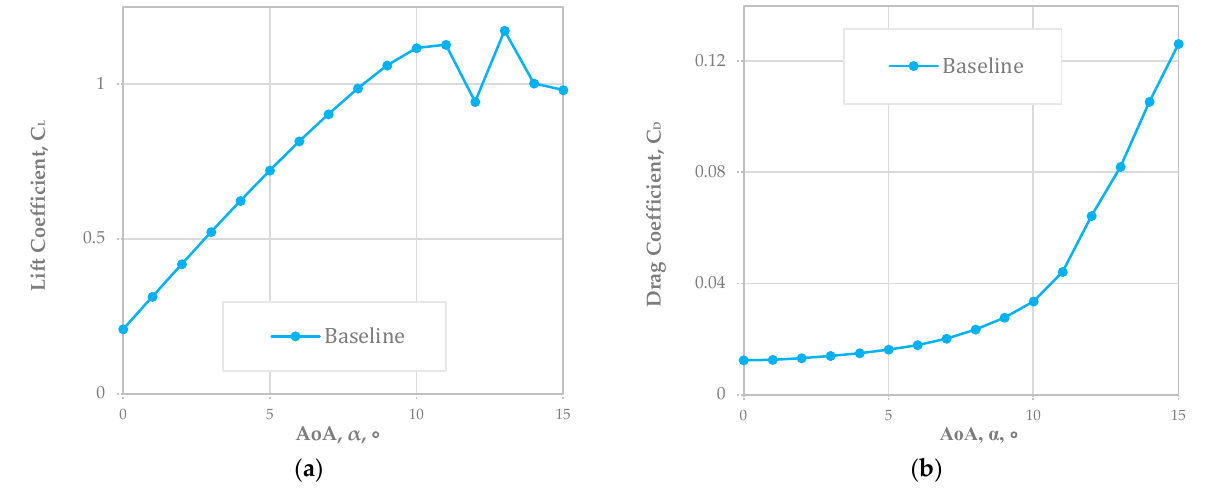
Figure 2. ( a ) 𝐶 (cid:3013) and ( b ) 𝐶 (cid:3005) plots of baseline NACA 2410 airfoil (Re = 778,179). Once the computational model for the airfoil was verified, the simulations for Table 2. Morphing (NACA 4410) and matching L conventional airfoils. comparison were run for the three morphed configurations when the AoA changed from 0 to 15°. The 𝐶 (cid:3013) morphed configurations were adequately matched against the conventional airfoil using flap-angle variations and by computing the 𝐿 values of deflected configurations at each AoA to match the 𝐿 values. The relationships between the camber rate and the flap-deflection angle are also presented in Tables 2–4. Additionally, Tables 2–4 present data for the 𝐶 (cid:3013) 𝐶 (cid:3005) ⁄ and for the endurance ratio ( 𝐶 (cid:3013)(cid:2869).(cid:2873) 𝐶 (cid:3005) ⁄ ). Table 2. Morphing (NACA 4410) and matching 𝐿 conventional airfoils.